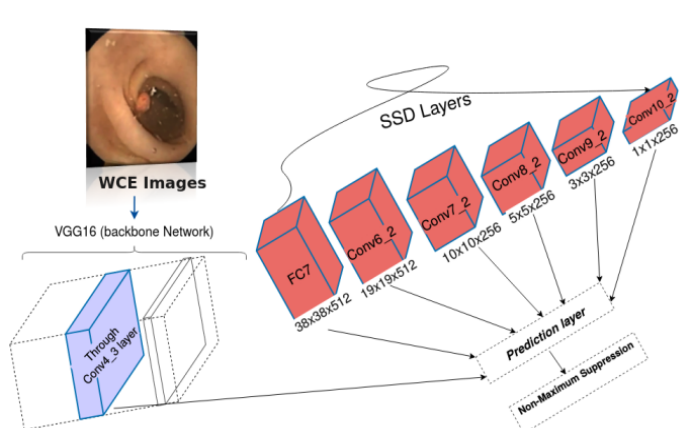
Figure 1. Framework of the traditional